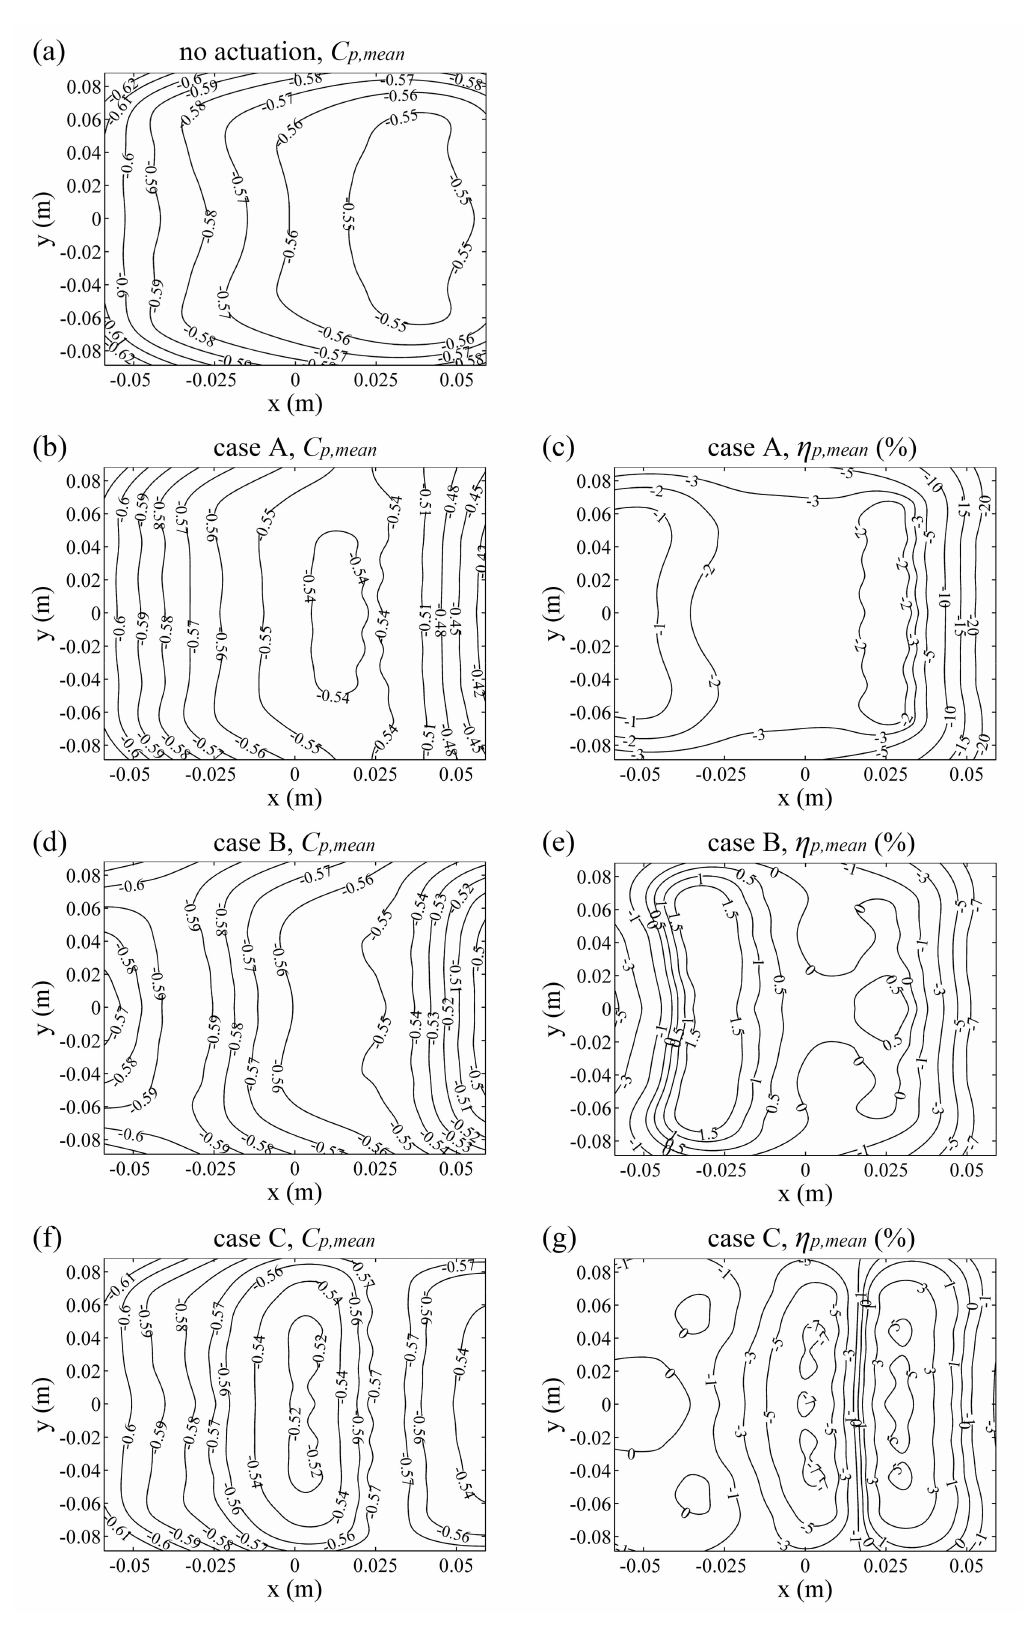
Figure 12. Contours of the mean pressure coe ffi cient and its change rate on the whole roof: ( a ) no actuation; ( b , c ) case A; ( d , e ) case B; ( f , g ) case